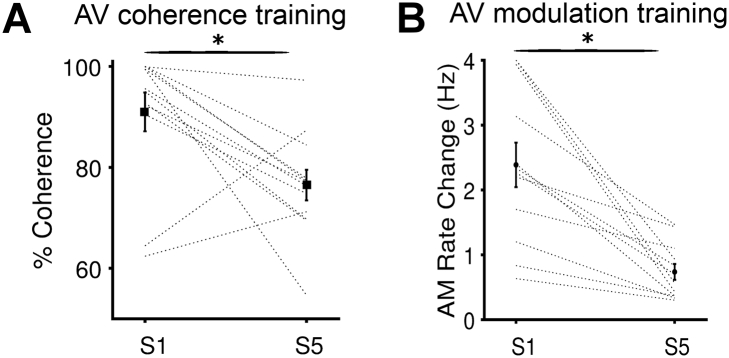
Training improved performance in trained tasks and the Auditory Selective Attention task. A Training in audiovisual temporal coherence detection (AV coherence training) task was effective at driving an improvement in the coherence detection threshold between session (S1) and session 5 (S5). Black vertical lines show the mean ± SEM across participants. Gray lines are individual participants. B Training in audiovisual amplitude modulation (AV modulation training) was effective at driving an improvement in AM rate discrimination between S1 and S5.